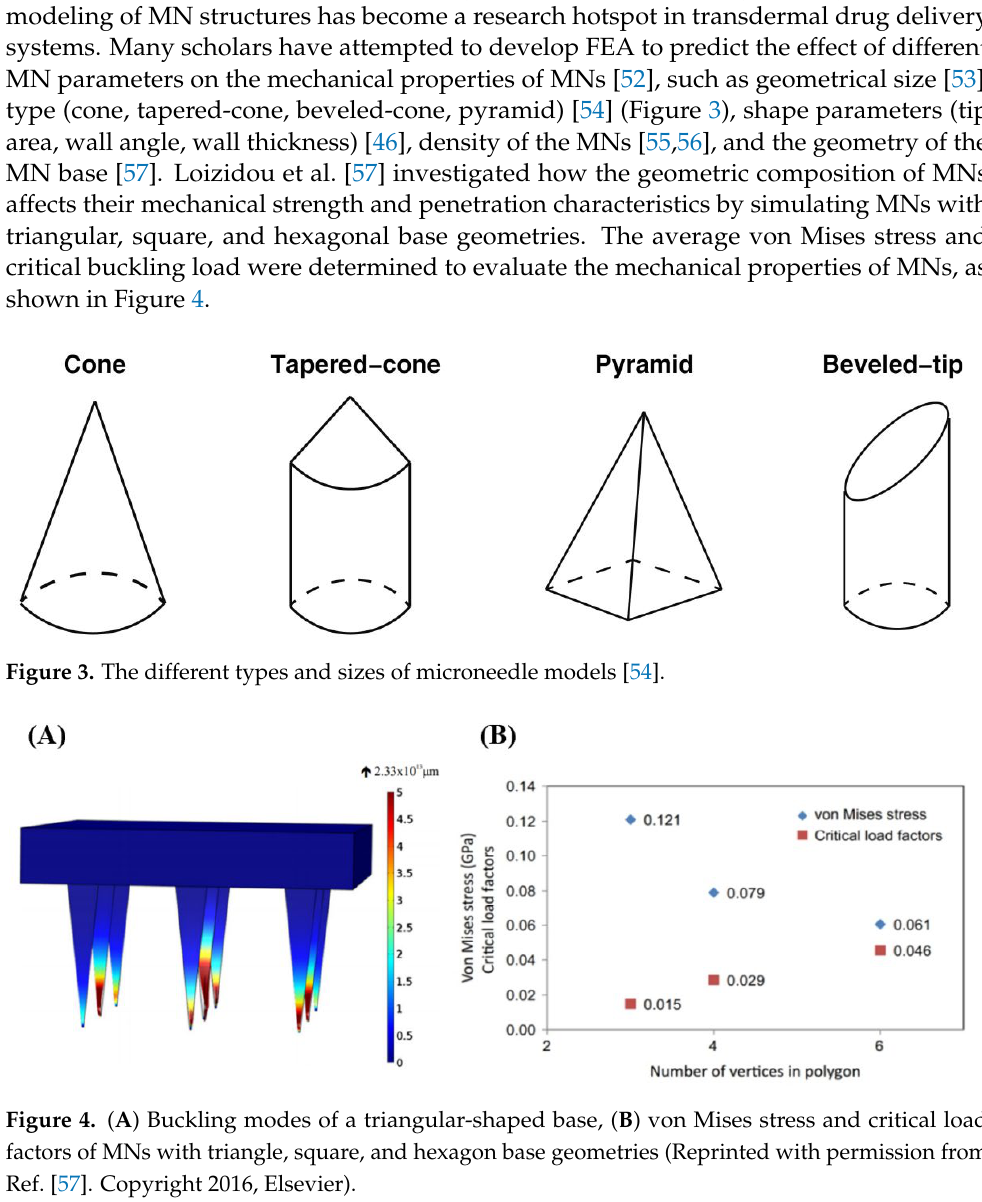
Figure 4. ( A ) Buckling modes of a triangular-shaped base, ( B ) von Mises stress and critical load factors of MNs with triangle, square, and hexagon base geometries (Reprinted with permission from Ref. [57] . Copyright 2016, Elsevier).